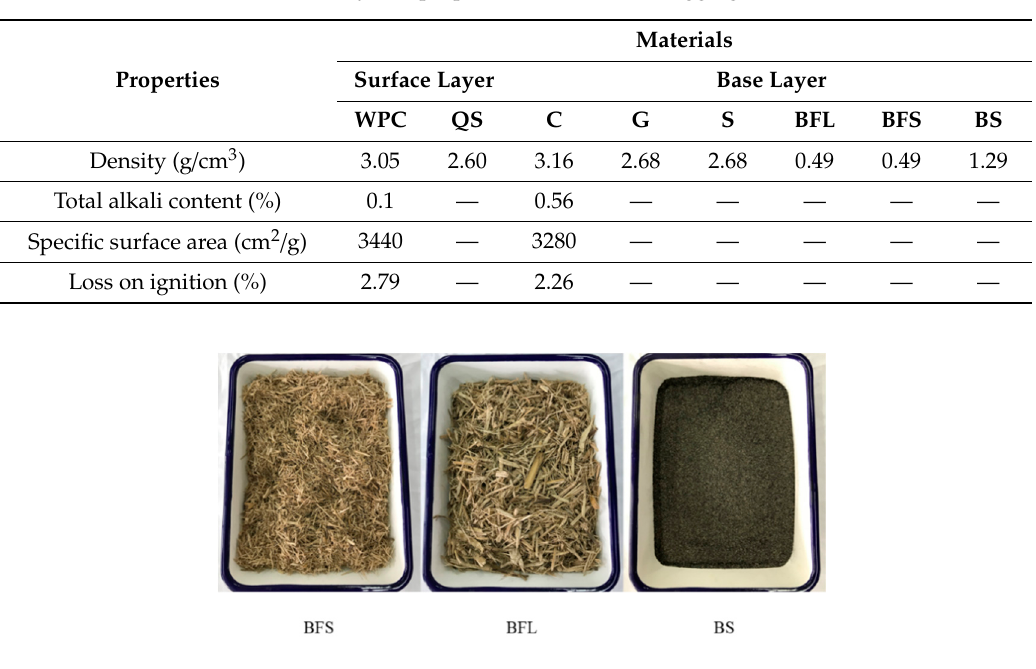
Table 1. Physical properties of cement and aggregates.